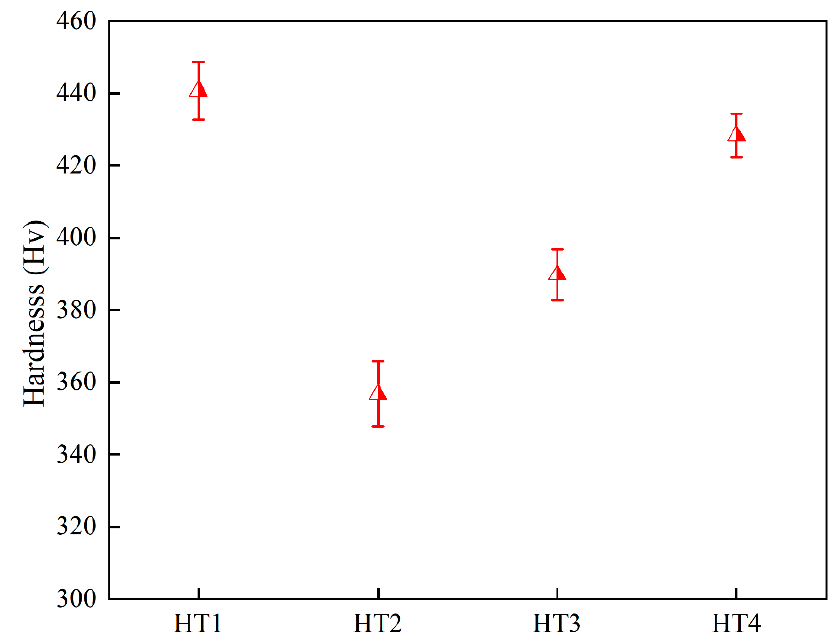
Figure 5. Vickers hardness under different aging treatment processes.